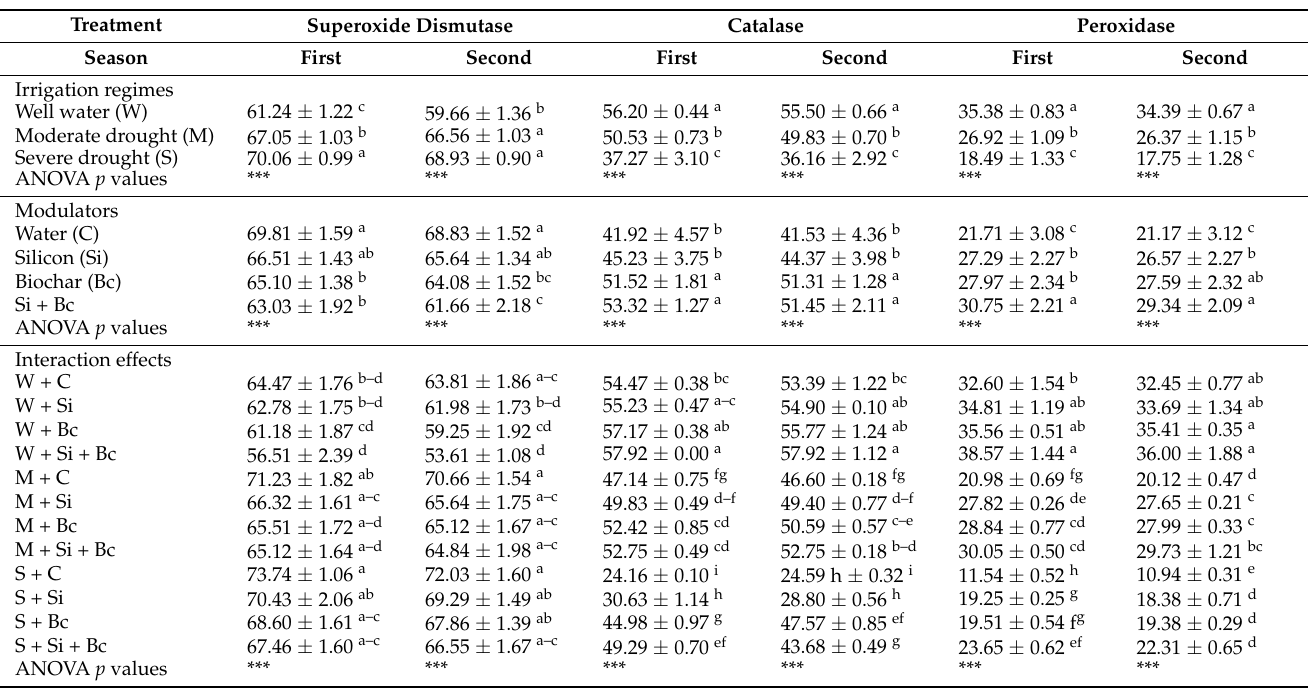
Table 2. Effect of irrigation regimes, silicon, biochar and their interaction on some